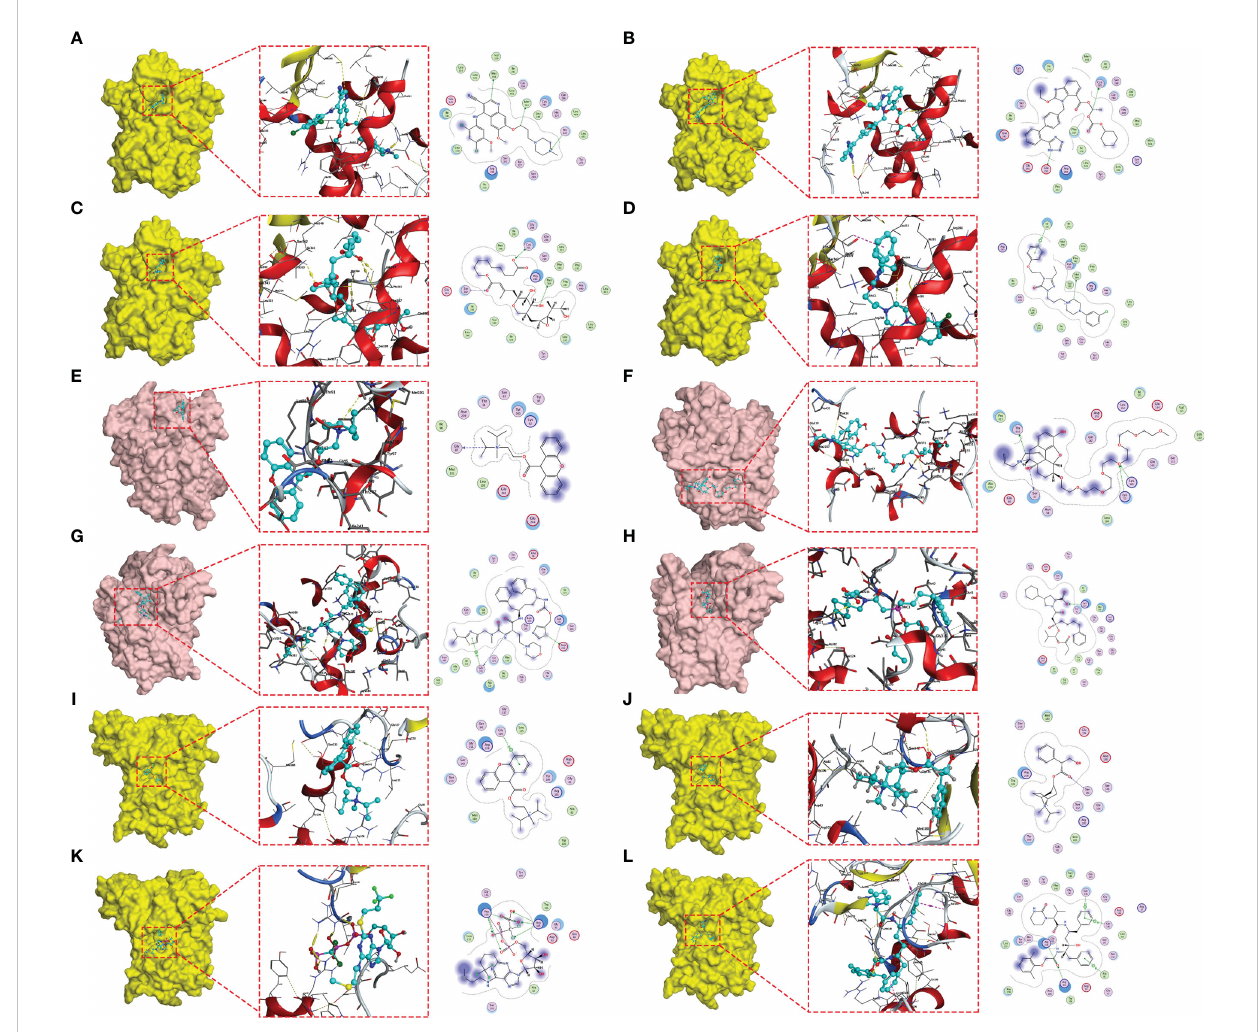
FIGURE 9 Molecular docking posture. Candidate drugs and target proteins screened using molecular docking. The Figure shows the docking position of the PPARG active pocket with Bosulif (A) , Candesartan (B) , Centany (C) and Nefazodone (D) . Docking position of the SLC7A9 active pocket with Propantheline (E) , Naloxegol (F) , Cobicistat (G) and Fosinopril (H) . Docking position of GALK1 active pocket with Propantheline (I) , Ipratropium (J) , Cangrelor (K) and Lopinavir (L)